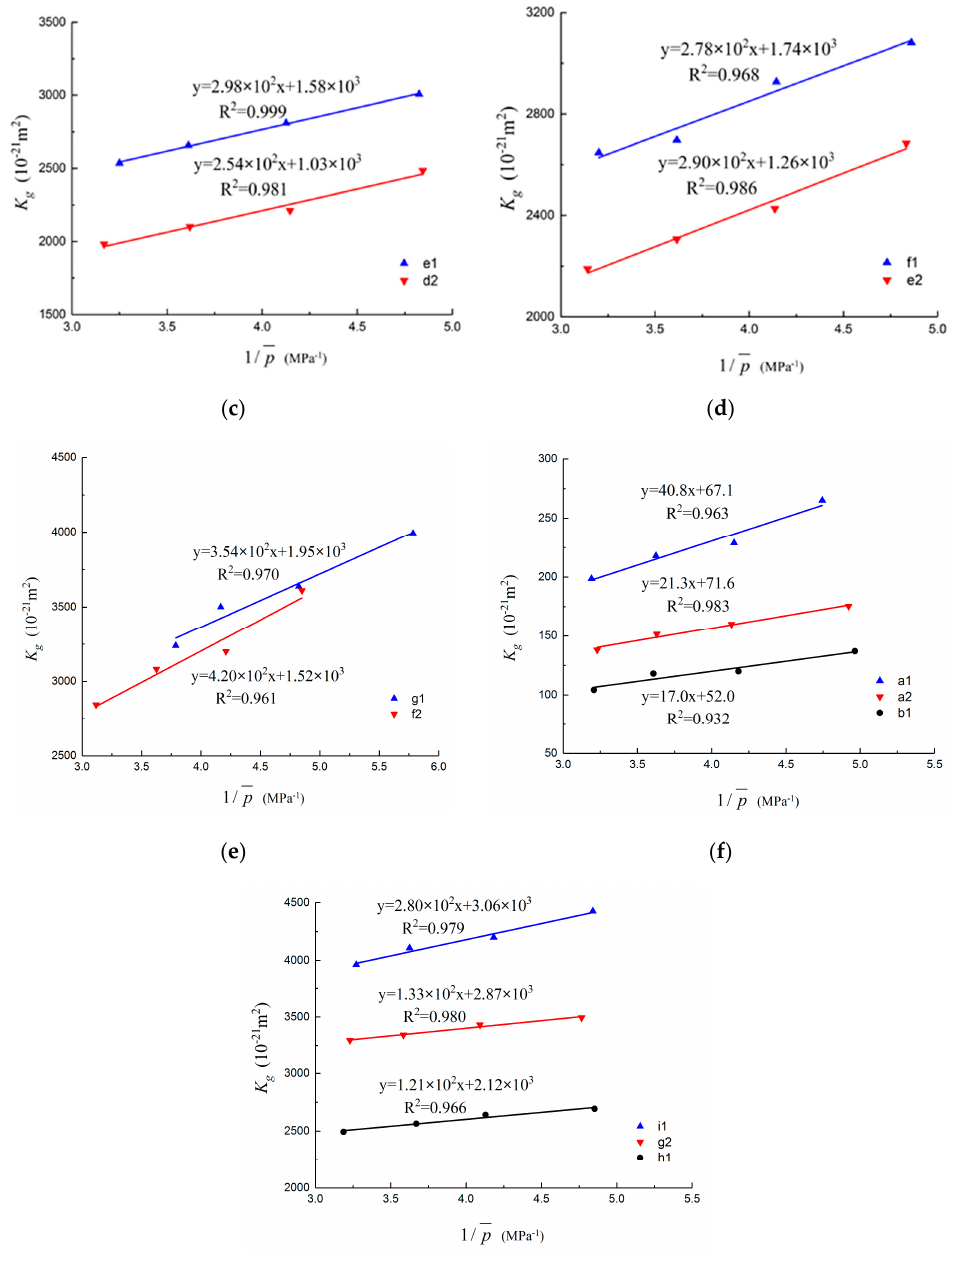
Figure 10. Fitting results of K g and 1/ p . ( a ) Mudstone content is 20%; ( b ) mudstone content is 40%; ( c ) mudstone content is 50%; ( d ) mudstone content is 60%; ( e ) mudstone content is 80%; ( f ) synthetic pure rock salt and synthetic pure rock salt with binder; ( g ) synthetic pure mudstone and synthetic pure mudstone with binder.